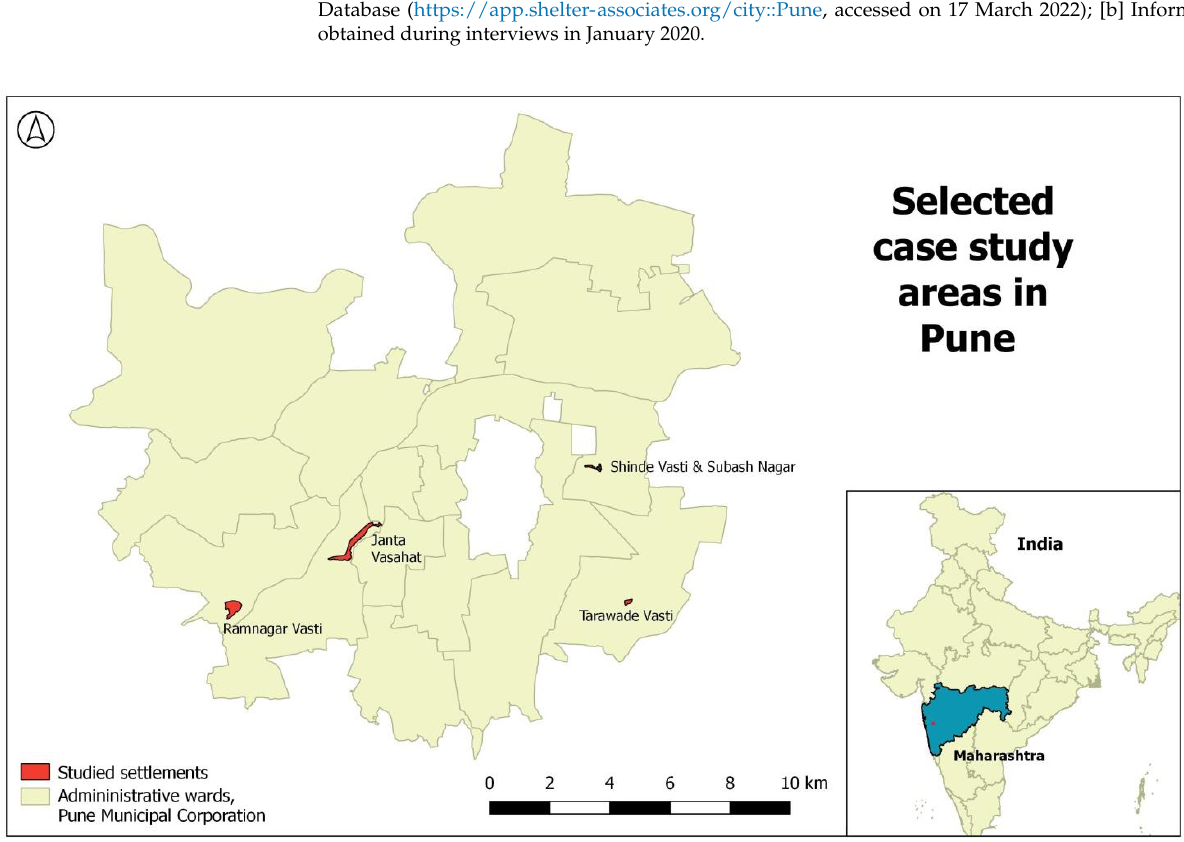
Figure 1. Selected case study areas for the settlements Shinde Vasti, Janta Vasahat, Ramnagar Vasti, and Tarawade Vasti, detailed maps (incl. water supply infrastructure, road access, etc.) can be found here: https://app.shelter-associates.org/city::Pune (accessed on 17 March 2022).